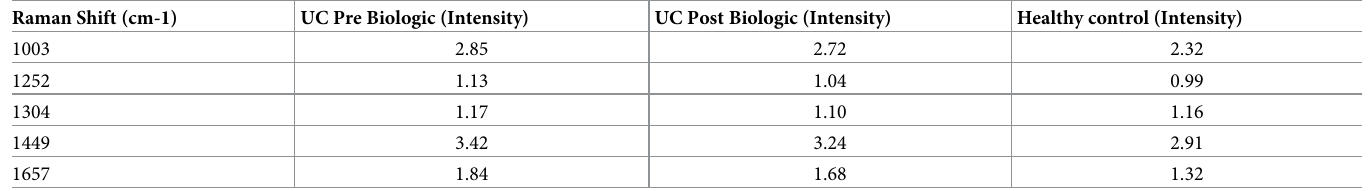
Table 5. Relative intensity of Raman shifts between UC pre biologic and post biologic and HC taken from SOMDI. Raman Shift